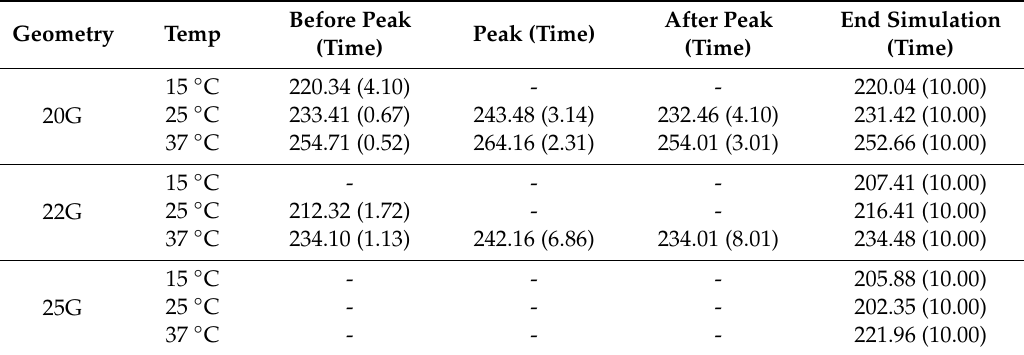
Table 5. Maximum shear rate values (Pa) and time (s).